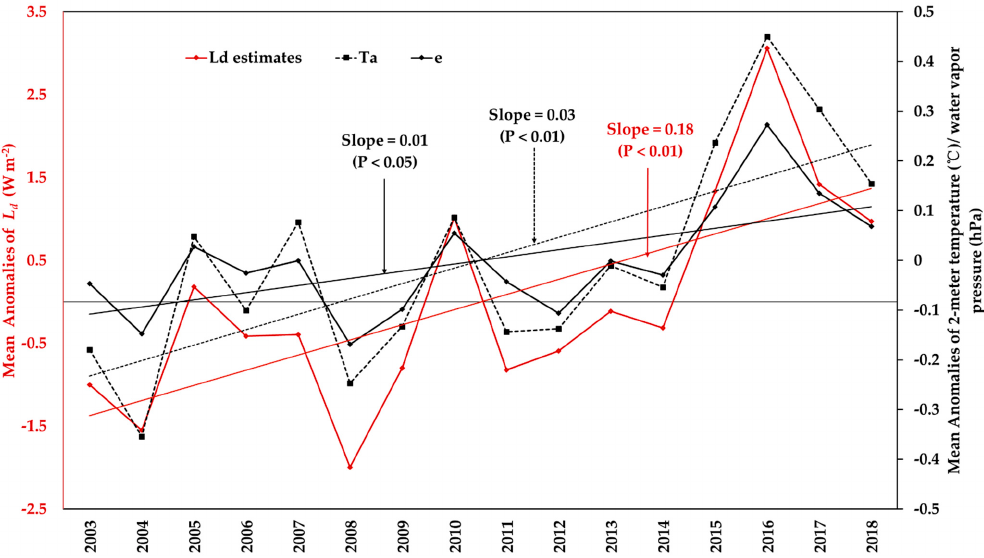
Figure 11. The trend of the annual mean anomalies of the generated L d estimation, ERA5 2-m air temperature, and water vapor pressure from 2003 to 2018.